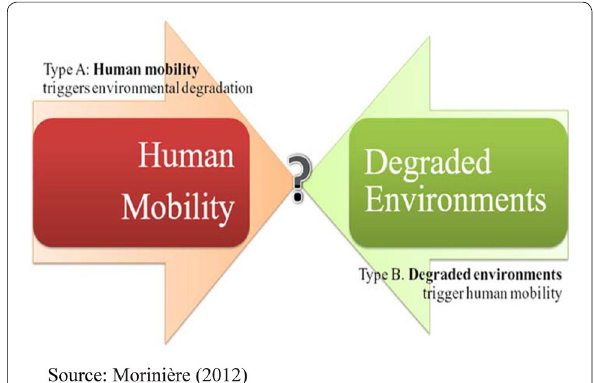
Table 1 Land use/land cover changes in Ethiopia